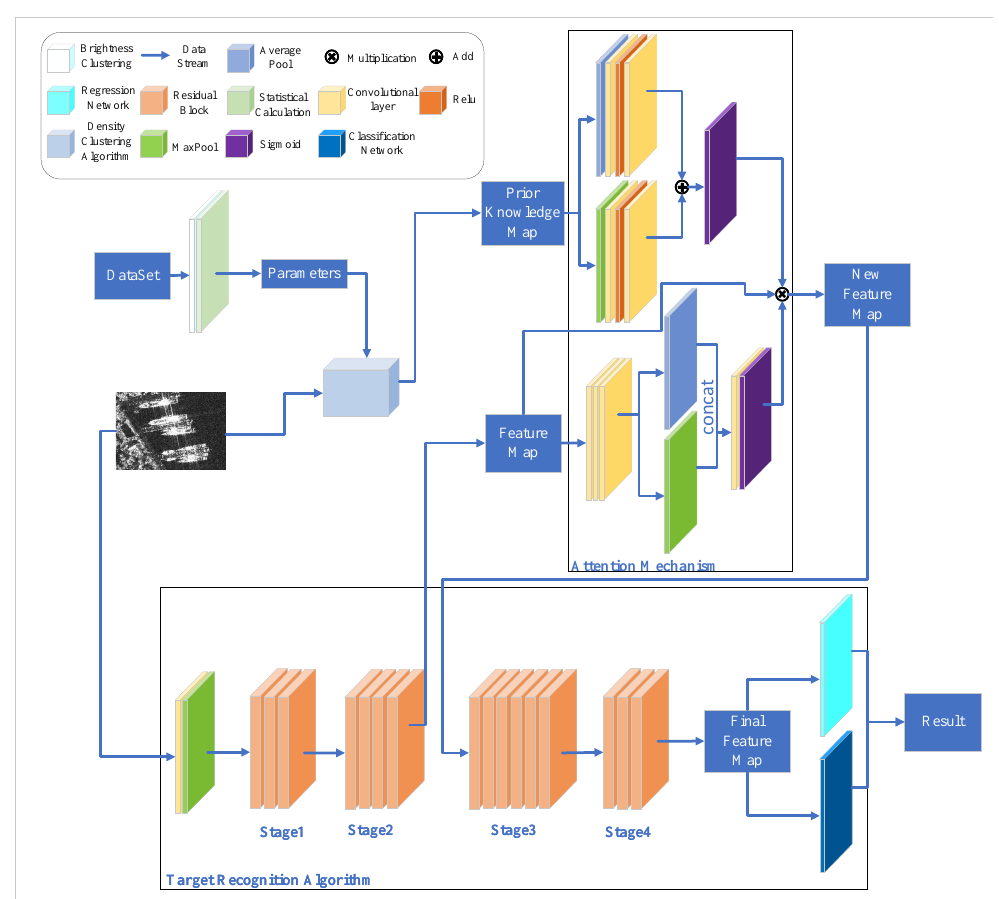
Figure 5. The comprehensive architecture of our framework. It consists of backbone, BDAM, and a prior knowledge